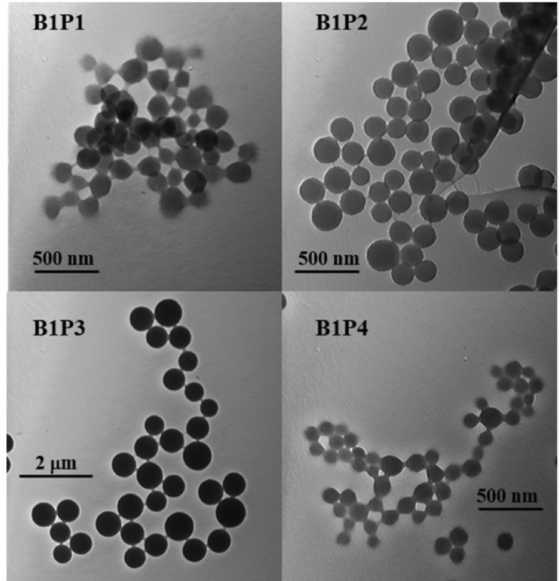
Figure 5. Transmission electronic microscopy (TEM) images of polymers B1P1, B1P2, B1P3 and B1P4 synthesized by precipitation polymerization. (Reprinted from Hoji, A., et al., Syntheses of BODIPY-incorporated polymer nanoparticles with strong fluorescence and water compatibility. Eur. Polym. J. 2020, with permission from